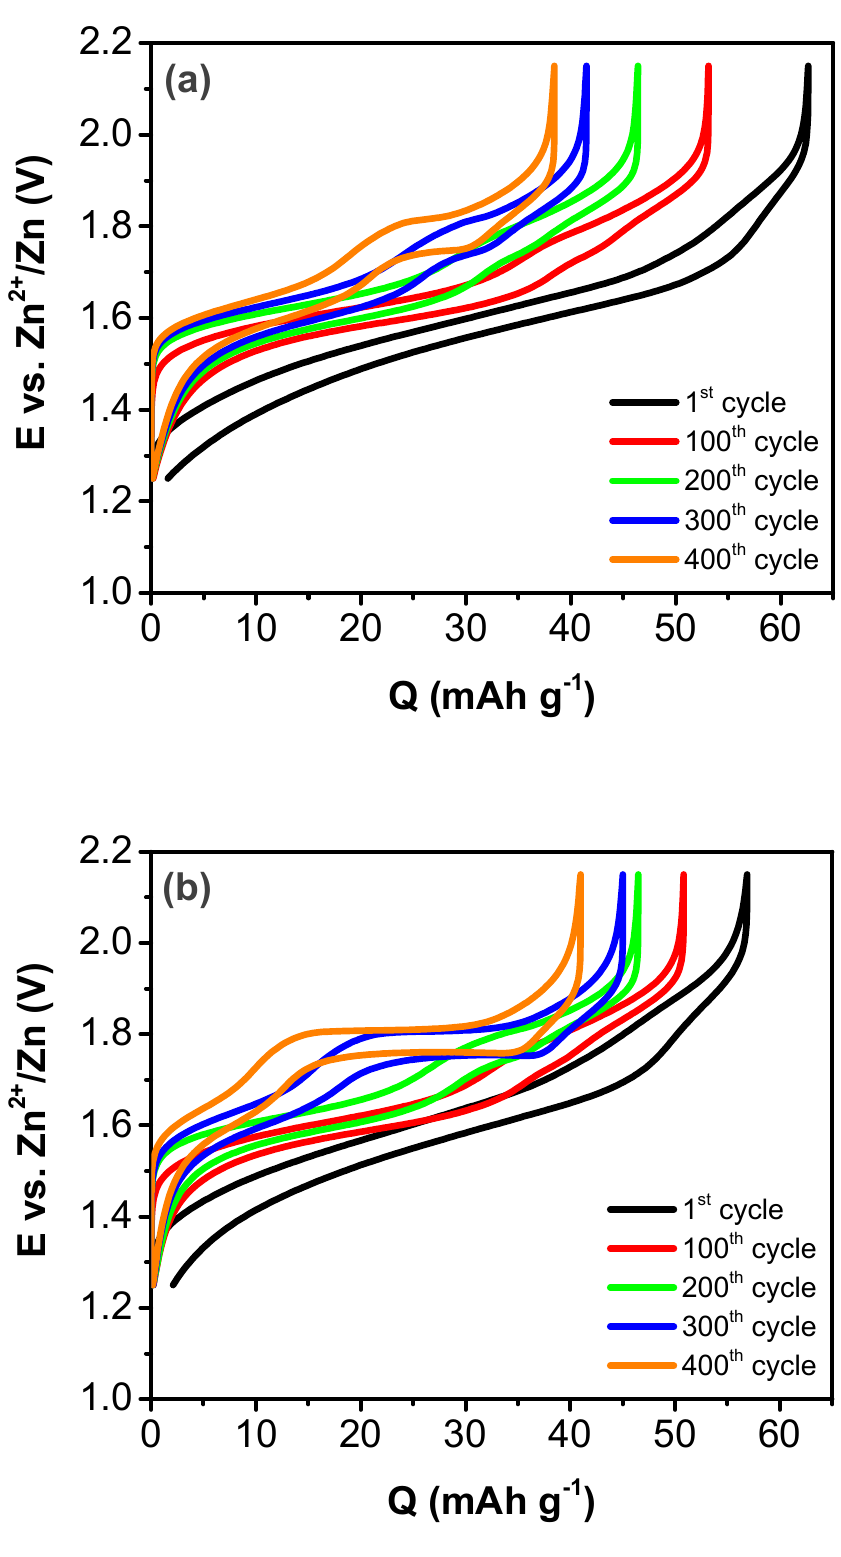
Figure 9. Galvanostatic cycles of ( a ) untreated and ( b ) 100 °C-annealed CuHCF electrodes, recorded at a C-rate of 1C.